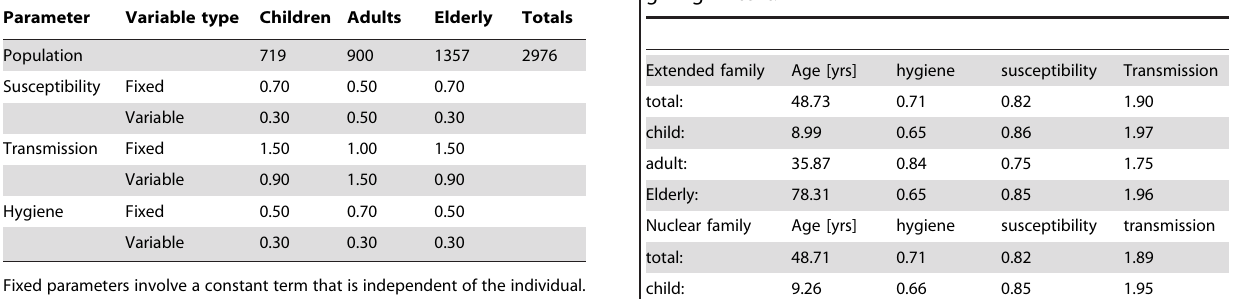
Table 3. A summary of the average value for various parameters listed in Eqn (1) that are used in the examples giving in text.